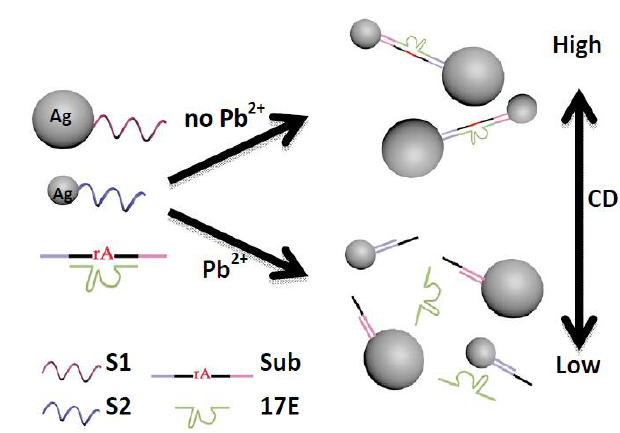
Figure 1. The principle of a DNAzyme-based chirality sensor for Pb 2+ detection.